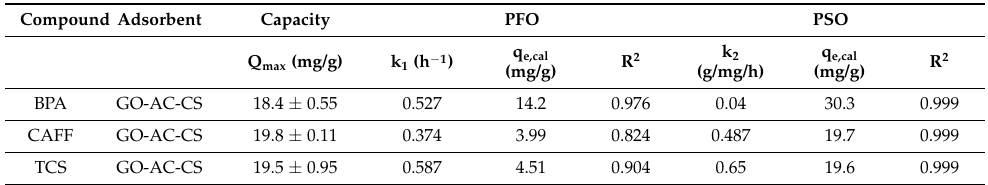
Table 4. PFO and PSO kinetic parameters for the adsorption of BPA, CAFF, and TCS personal care products from aqueous solutions, over GO-AC-CS composite adsorbents